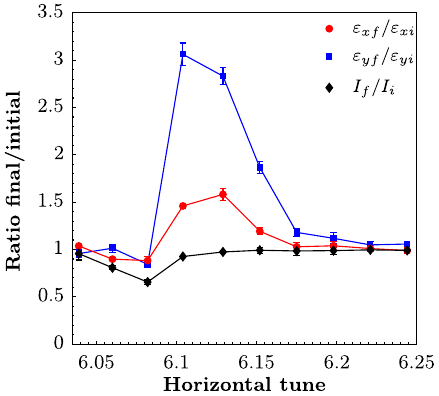
FIG. 3. Measured emittance growth and beam intensity as a function of the horizontal tune. Error bars are obtained from the statistical fluctuation resulting from three consecutive measurements.